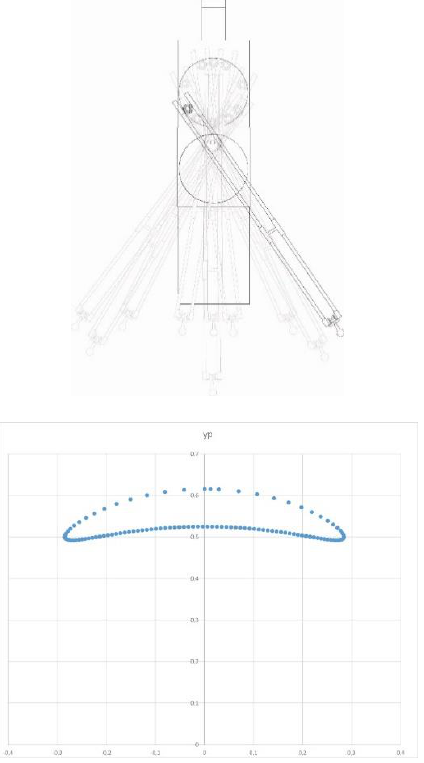
Fig.4.The image shows the qualitative trend of the lamp's speed by observing the distance between the various points of the trajectory graph. In addition, the trajectory reported corresponds to a series of crank rotations, which have a constant